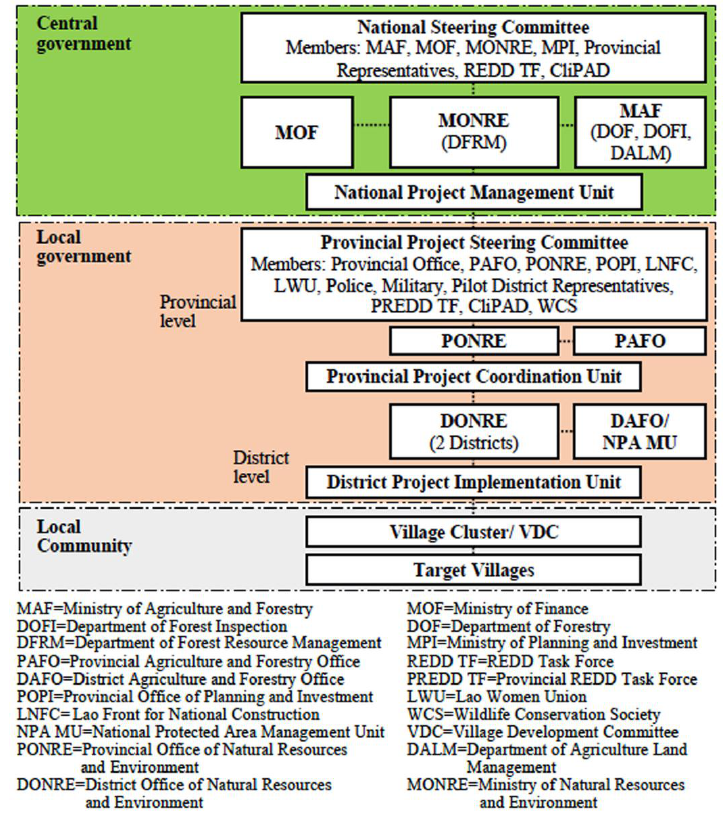
Figure 1. Institutional structure and implementation arrangements of CliPAD. Source: adapted from CliPAD Progress Report No. 7 [39].